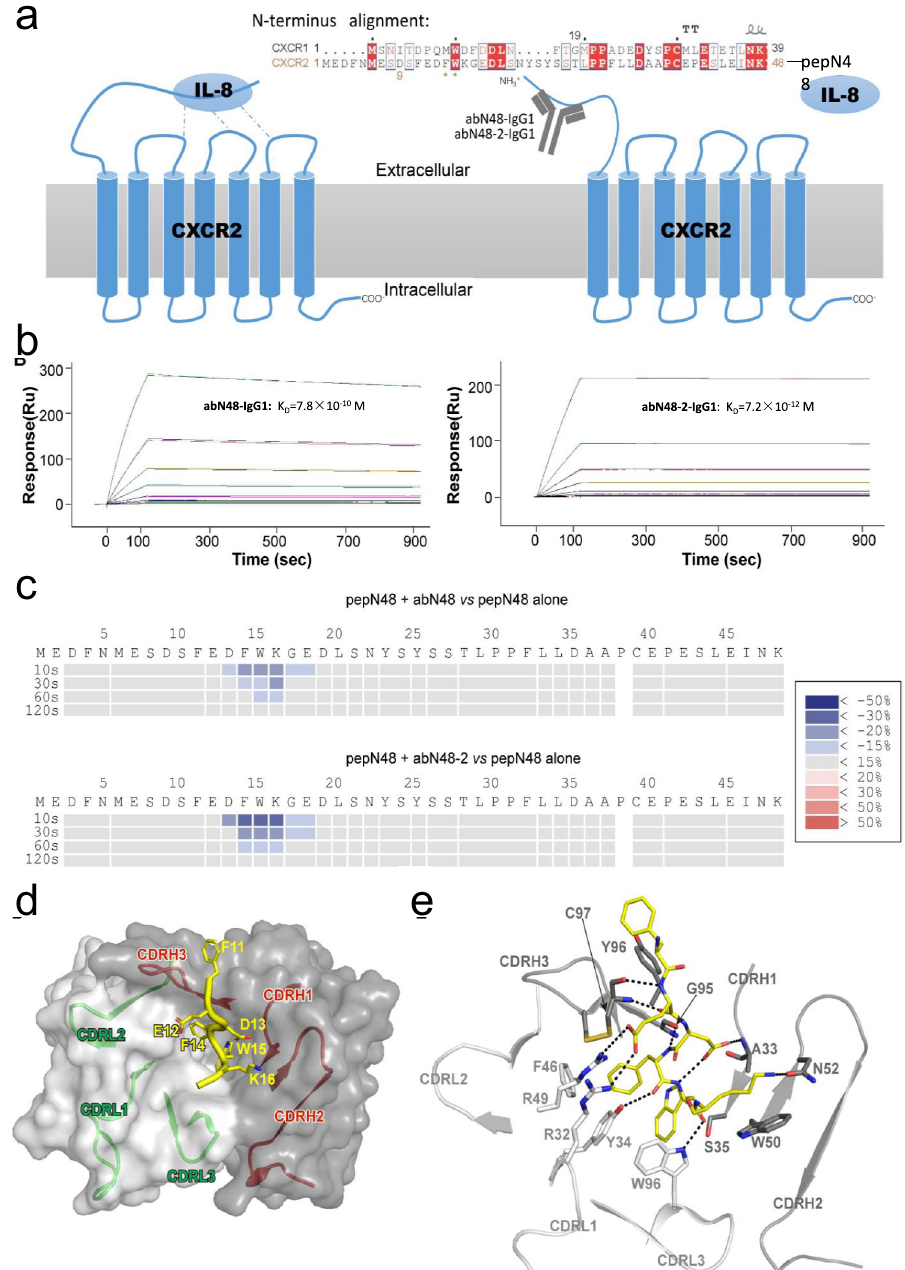
Fig. 1 Epitope-guided selection of tight binding antibodies for h CXCR2. a Schematic illustration of antibodies selected by phage panning based on the IL-8 epitope on the extracellular N-terminus of h CXCR2 (pepN48). b Binding af fi nity measurements of two combinatorial antibodies, abN48-IgG1 and abN48-2- IgG1 by SPR assay on a Biacore T200. Curves in the sensorgram plots represent a range of concentrations of antibody solutions: 0.1, 0.5, 1, 2, 5 and 10 nM for abN48-IgG1 and 0.1, 0.2, 0.5, 1, 2, and 5 nM for abN48-2-IgG1. c HDX exchange for pepN48 in the presence of abN48-IgG1 (upper panel) or abN48-2- IgG1 (lower panel) as compared to free pepN48. The percentage difference in deuterium uptake values at different labeling time points is represented as heatmap, with light gray indicating no signi fi cant changes, red indicating increase, and blue indicating decrease in HDX exchange rates. d Crystal structure of pepN9-19 in complex with abN48-2 illustrating that the aromatic side chains of Phe14 and Trp15 from pepN9-19 snugly fi t into a cavity formed by the antibody CDR loops. The light and heavy chains of abN48-2 are shown as light and dark gray surfaces, respectively. The CDR loops of the heavy chain and light chain are depicted as red and green cartoons respectively and the surface representation was rendered transparent to show the location of the CDR loops. The backbone of bound pepN9-19 is depicted as a yellow tube with the side chains of critical residues as stick models. e Close-up view of the interface between pepN9-19 and abN48-2. Key residues involved in the antibody-antigen interface are shown as stick models and color-coded as following: light gray (light chain residues), dark gray (heavy chain residues), and yellow (pepN9-19 residues). Polar and electrostatic interactions are indicated with black dashed lines. The CDRs residues are labeled following Kabat